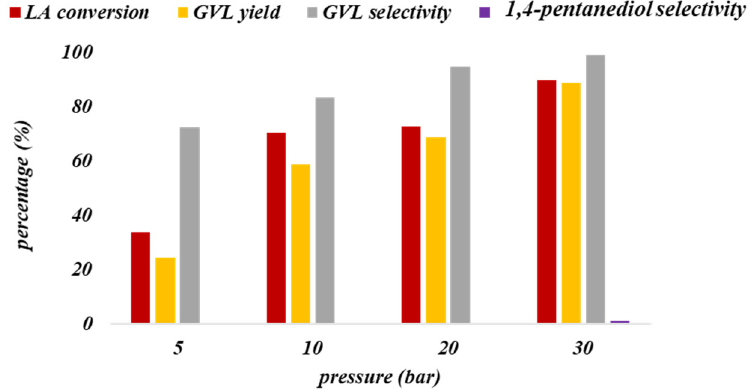
Figure 6. Pressure effect for levulinic acid HDO reaction over Ru/C H Zn cotton catalyst. Reaction conditions: 100 °C, 60 min, 10 mL of H 2 O, (LA) 0.5 M, 10 mg of catalyst.